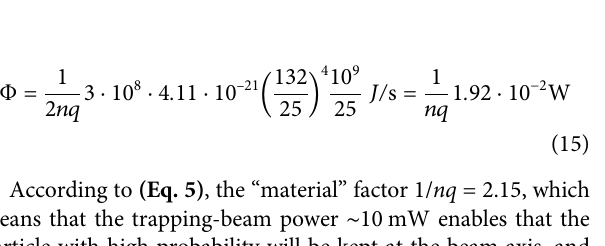
Frontiers in Physics |